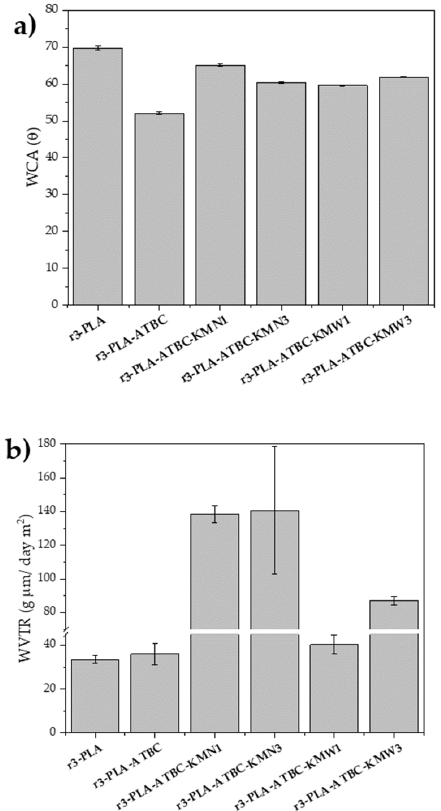
Figure 8. ( a ) Static water contact angle measurements and ( b ) water vapor transmission rate of 3r-PLA-ATBC-based films.